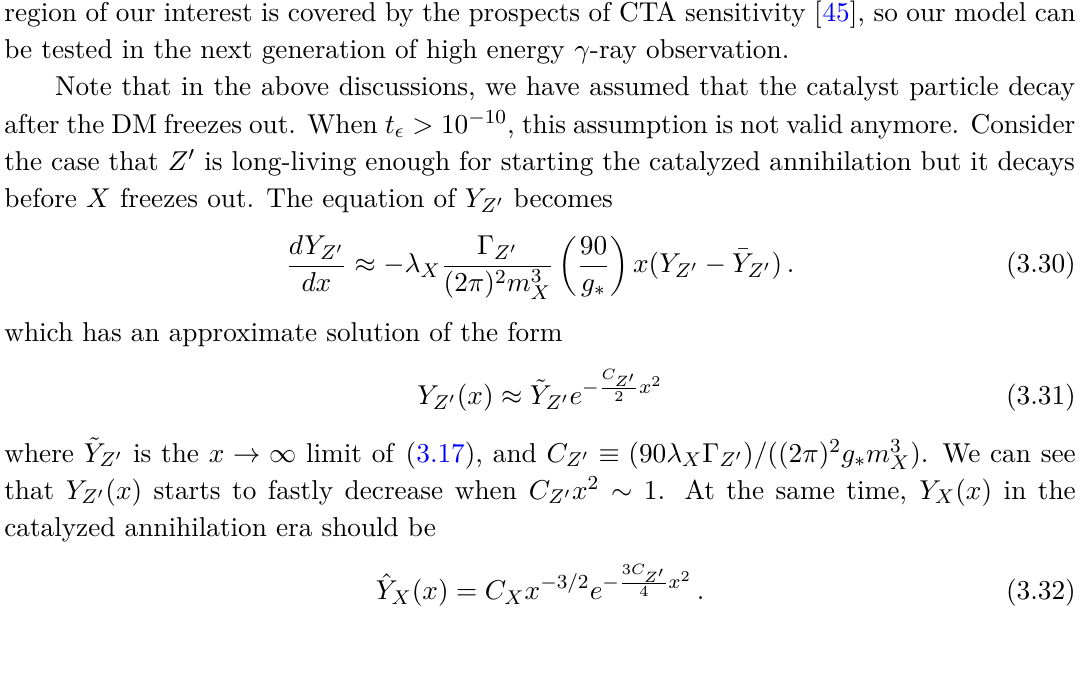
Figure 4 . The dark gray region is excluded by Fermi-LAT data [9] at 95% CL, while the light gray region is the prospect of CTA experiment [45]. Solid lines correspond to the parameters that reproduce Ω X h 2 = 0 . 12 [51] by choosing r 1 / 2 = 1 . 2 (red), 1 . 3 (green), and 1 . 4 (blue) and fixing t (cid:15) = XZ 0 10 − 11 , ξ X = ξ Z 0 = 10 − 5 . Dashed lines represent the cases by fixing t (cid:15) = 5 × 10 − 9 , ξ X = ξ Z 0 = 10 − 5 . light gray region is an estimation of future CTA experiment sensitivity. The solid colored lines represents the parameters which can obtain the Ω h 2 = 0 . 12 for r 1 / 2 = 1 . 2 (red), 1 . 3 X XZ 0 (green), and 1 . 4 (blue) with fixing t = 10 − 11 , ξ = ξ = 10 − 5 . We find that the region (cid:15) X Z 0 . 4 . 5 TeV has been excluded by the Fermi-LAT observation at 95% CL. The m X